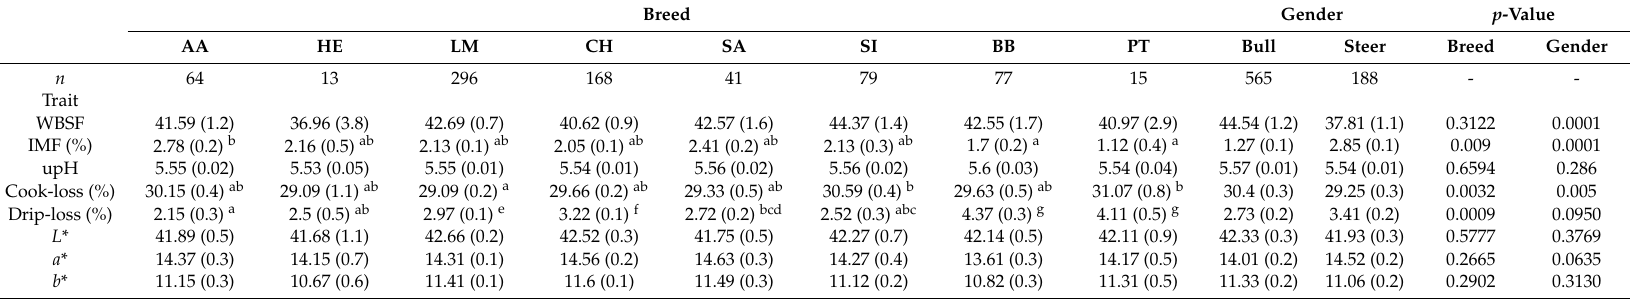
Table 2. E ff ect of breed and gender on quality traits of M. longissimus thoracis et lumborum (least squares mean and standard error). Breed Gender p -Value AA HE LM CH SA SI BB PT Bull Steer Breed